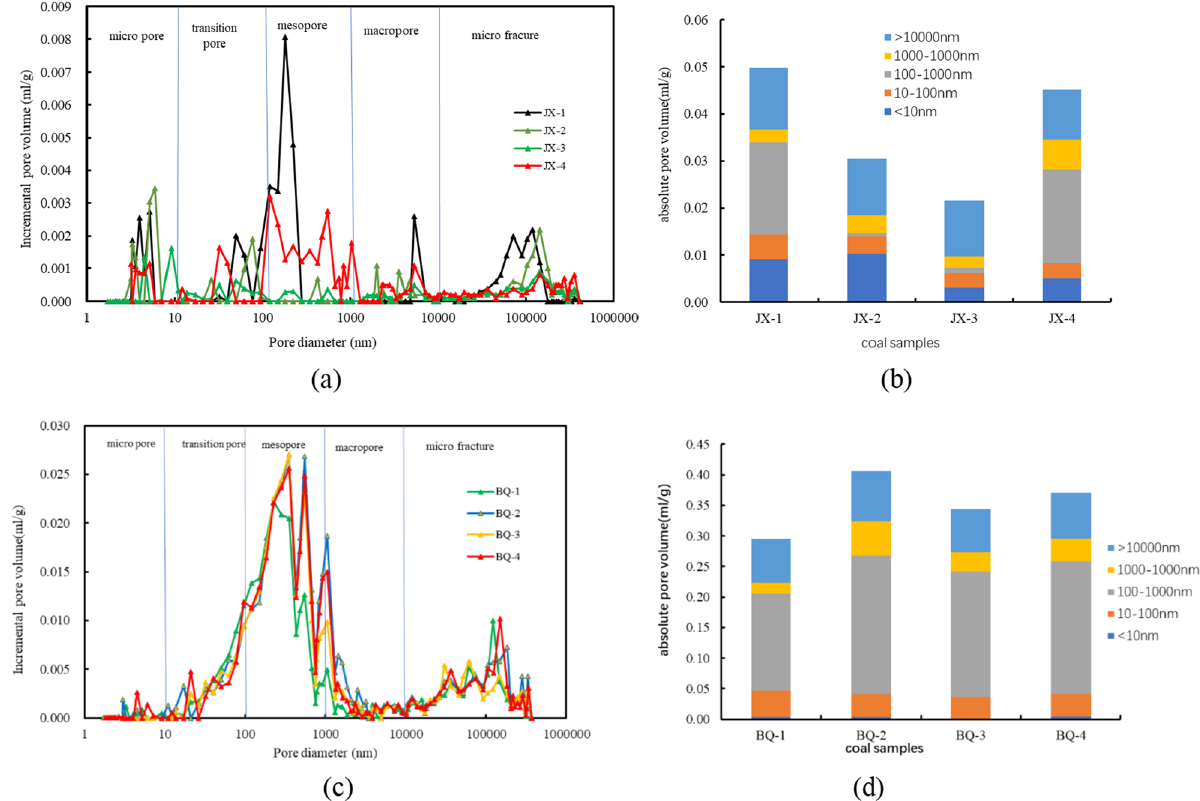
Figure 6. Modified pore size distributions and pore contents of different coal